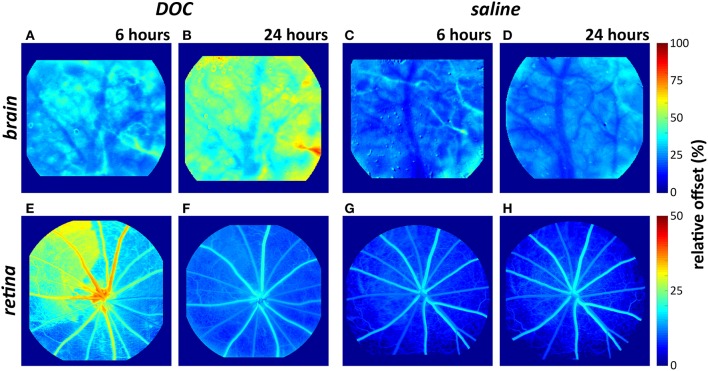
Representative color maps demonstrating changes to the “offset” in the brain (A–D) and retina (E–H) after DOC or saline infusion. The retinal vasculature showed an elevated offset (i.e., increased fluorescein retention) at 6 h but not 24 h. The cortical vasculature showed an elevated offset 24 h after DOC administration (warm colors in B).